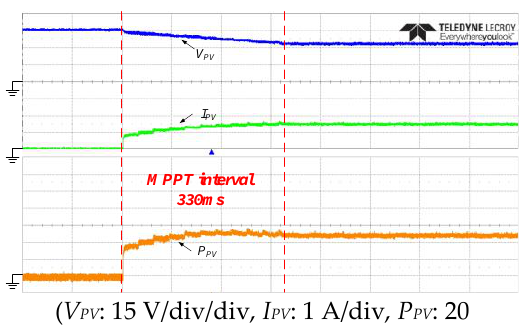
Figure 17. Measured battery voltage V B and current I B waveforms under step-load changes between I B = 0A and I B(max) = 12A when battery voltage V B = 8V.